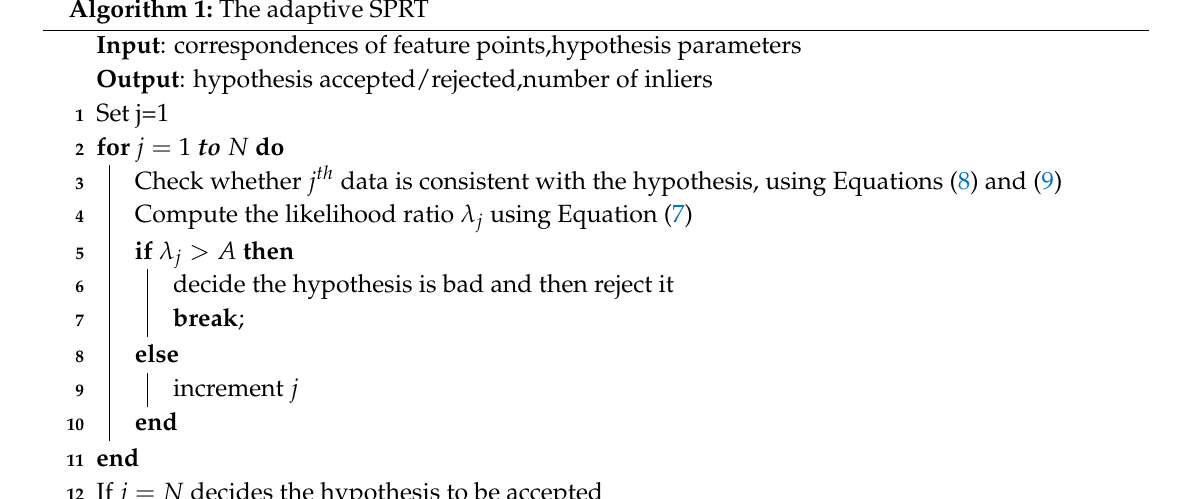
Algorithm 1: The adaptive